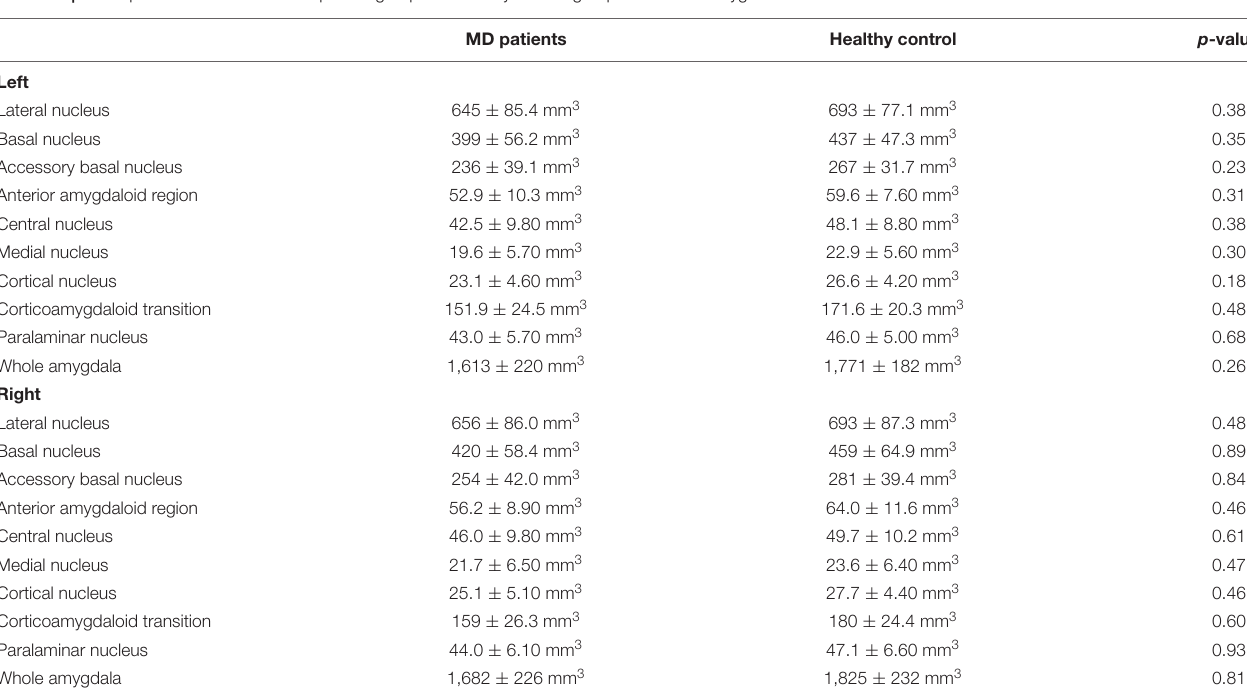
FIGURE 1 | Representative images of the amygdala subregions. The mask of each region overlaid on sagittal T1-weighted images from mid side to lateral side. TABLE 2 | A comparison between the MD patient group and healthy control group in nuclei of